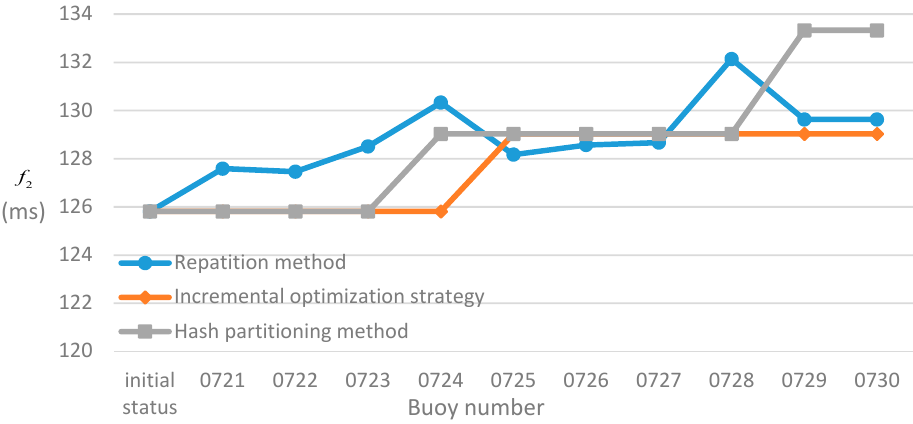
Figure 5. The change of the three methods on the f 2 when the buoy number